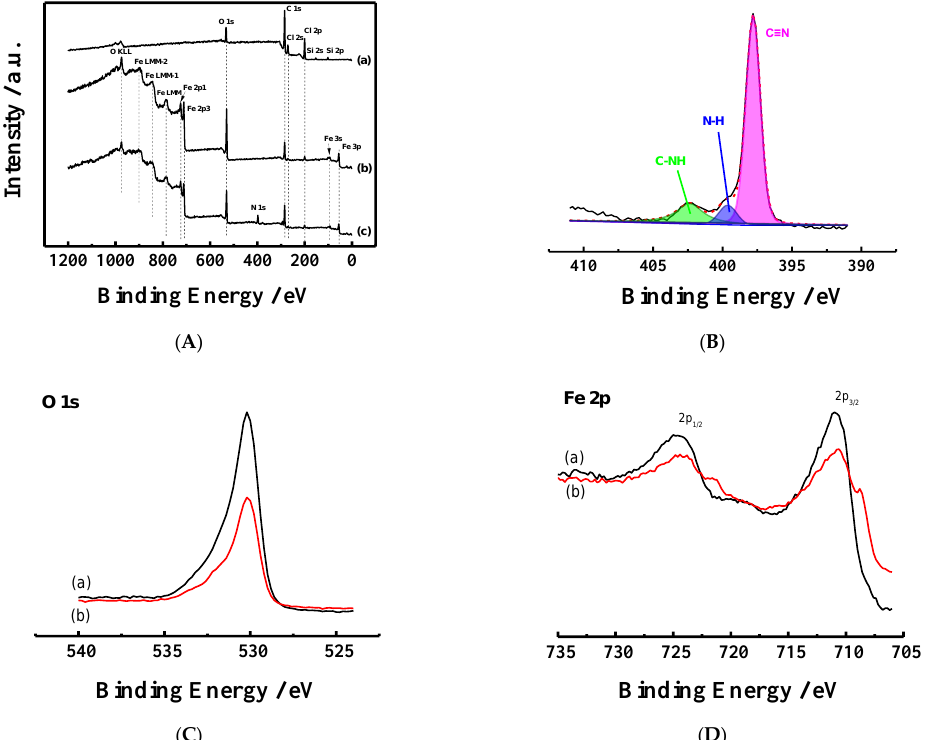
Figure 5. X-ray photoelectron spectrum: ( A ) XPS wide spectrum of (a) bare SPCE, (b) SPCE/nano- Fe 3 O 4 , and (c) SPCE/nano-Fe 3 O 4 /PBNC. ( B ) XPS narrow spectrum of N 1s of the SPCE/nano- Fe 3 O 4 /PBNC. XPS narrow spectrum of ( C ) O 1s, and ( D ) Fe 2p of (a) SPCE/nano-Fe 3 O 4 , and (b) SPCE/nano-Fe 3 O 4 /PBNC. The absorption spectrum of SPCE/nano-Fe 3 O 4 /PBNC presented a different pattern compared to nano-Fe 3 O 4 powder. The FTIR spectrum obtained from nano-Fe 3 O 4 exhibited an intense peak at 584.7 cm − 1 attributed to the stretching of the Fe – O bond; a broad band centered at 3437.5 cm − 1 was attributable to the stretching and bending vibration of the hydroxyl groups (Figure 6, Spectrum b). Meanwhile, the ATR-FTIR spectrum of SPCE/nano-Fe 3 O 4 /PBNC showed a new strong peak at 2083.8 cm − 1 arising from the stretch- ing vibration of the Fe(III) – CN – Fe(II) structure (Figure 6, Spectrum a), pointing out the PB formation [16 – 18].